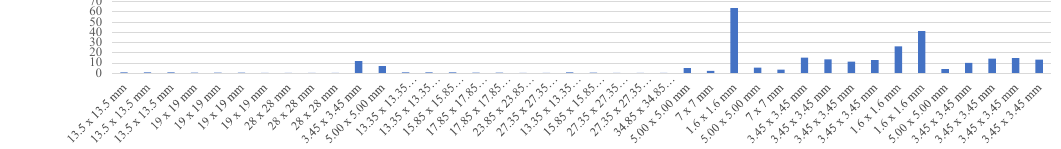
(Lm/W) / mm 010203040506070